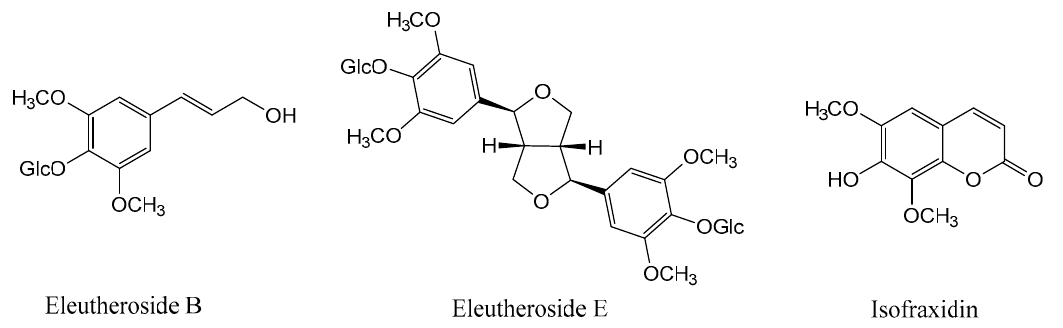
Figure 1. Chemical structures of eleutherosides B and E and isofraxidin [24,25].